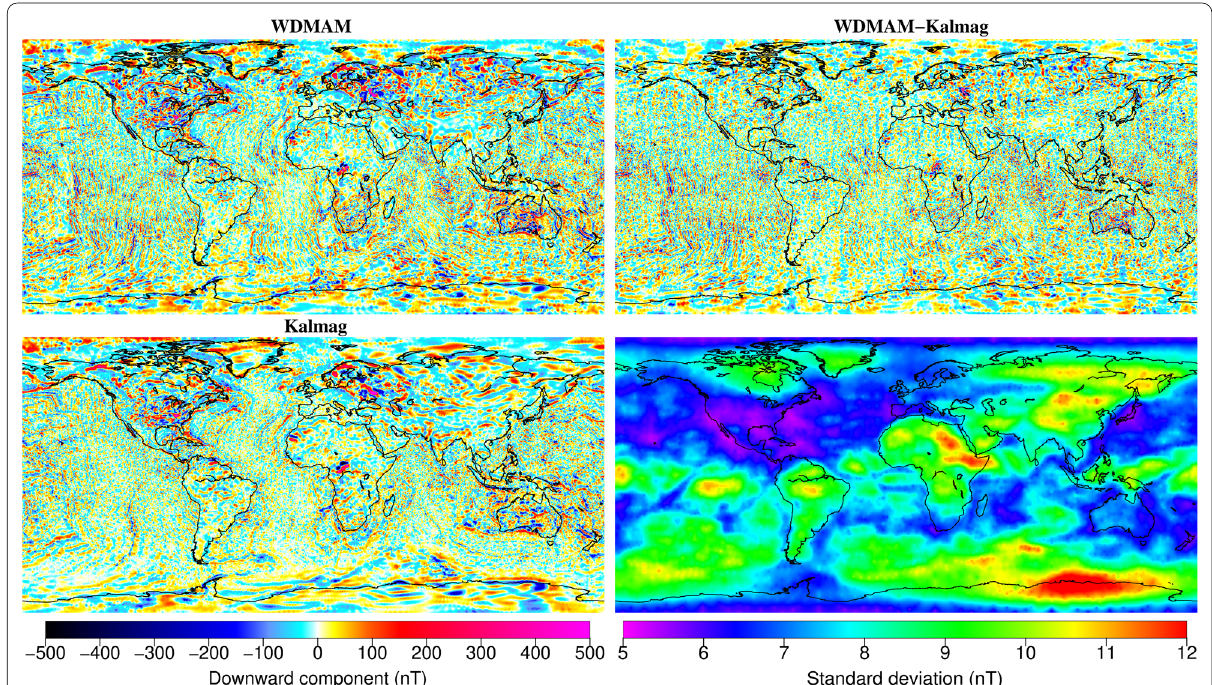
Fig. 8 Downward component of the lithospheric field at the Earth’s surface expanded up to spherical harmonics degree ℓ = 450 for the WDMAM model by Lesur et al. (2016) (top left), the Kalmag model (bottom left), and the difference between the WDMAM and the Kalmag model (top right). The color scale for these three maps is displayed below the mean Kalmag solution. Bottom right: standard deviation associated with the Kalmag mean downward component expanded up to ℓ = 100